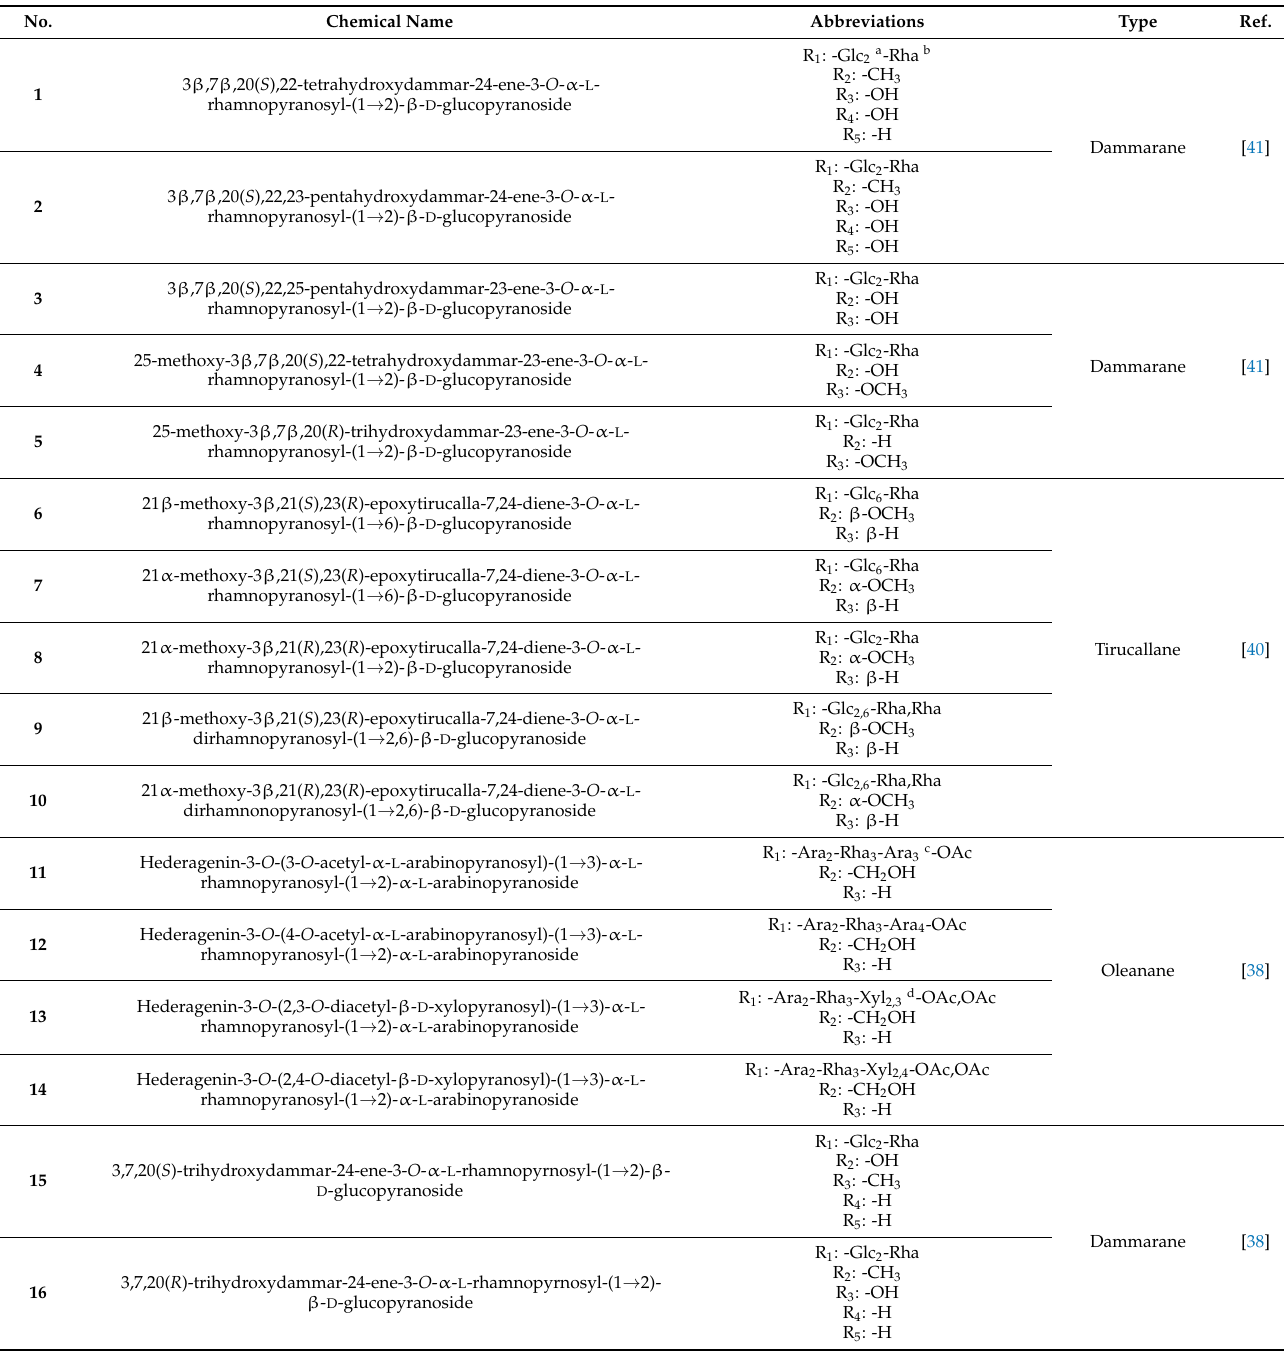
Table 1. Sapindus mukorossi saponins present in different parts of the